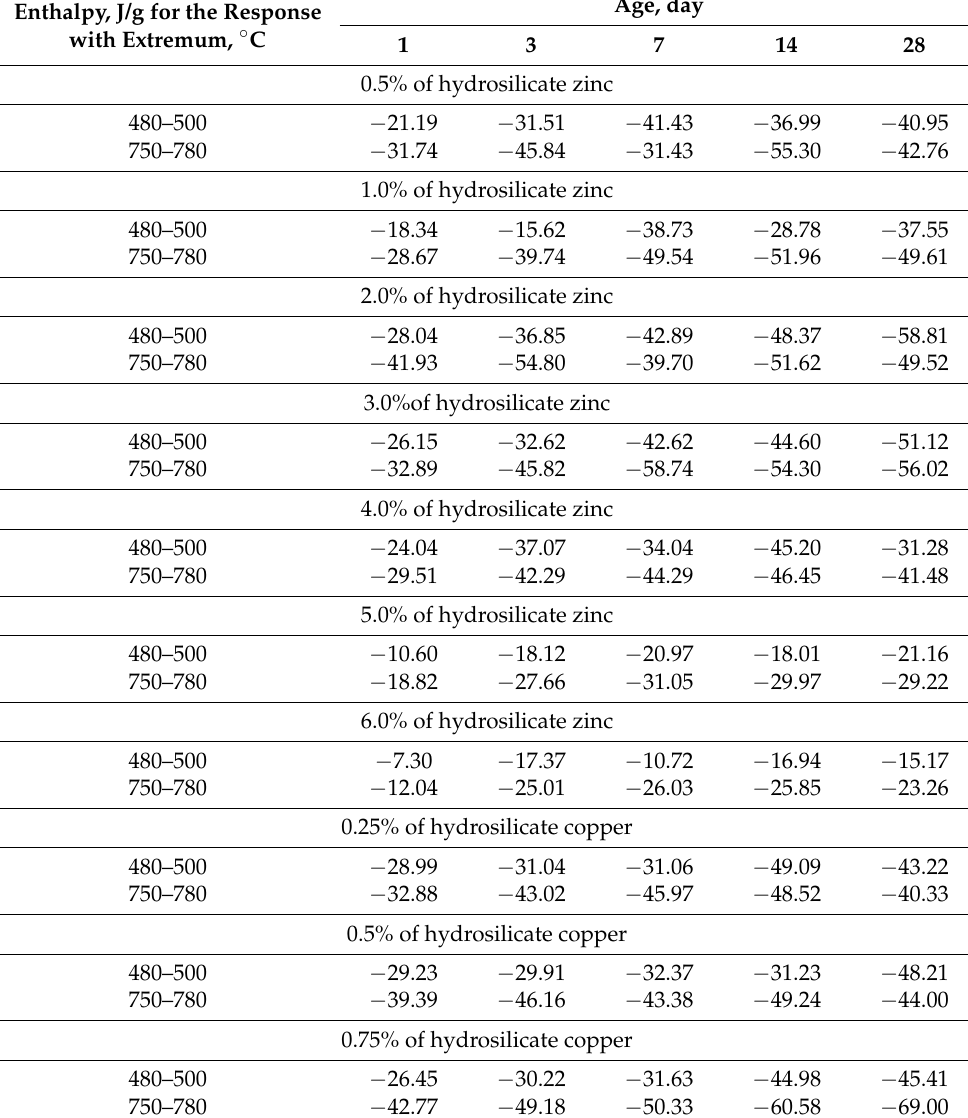
Figure 2. Thermogram of a cement stone modified with barium hydrosilicates and copper hydrosilicates (0.5%): 1—at the age of 1 day; 2—at the age of 3 days; 3—at the age of 7 days; 4—at the age of 14 days; 5—at the age of 28 days.